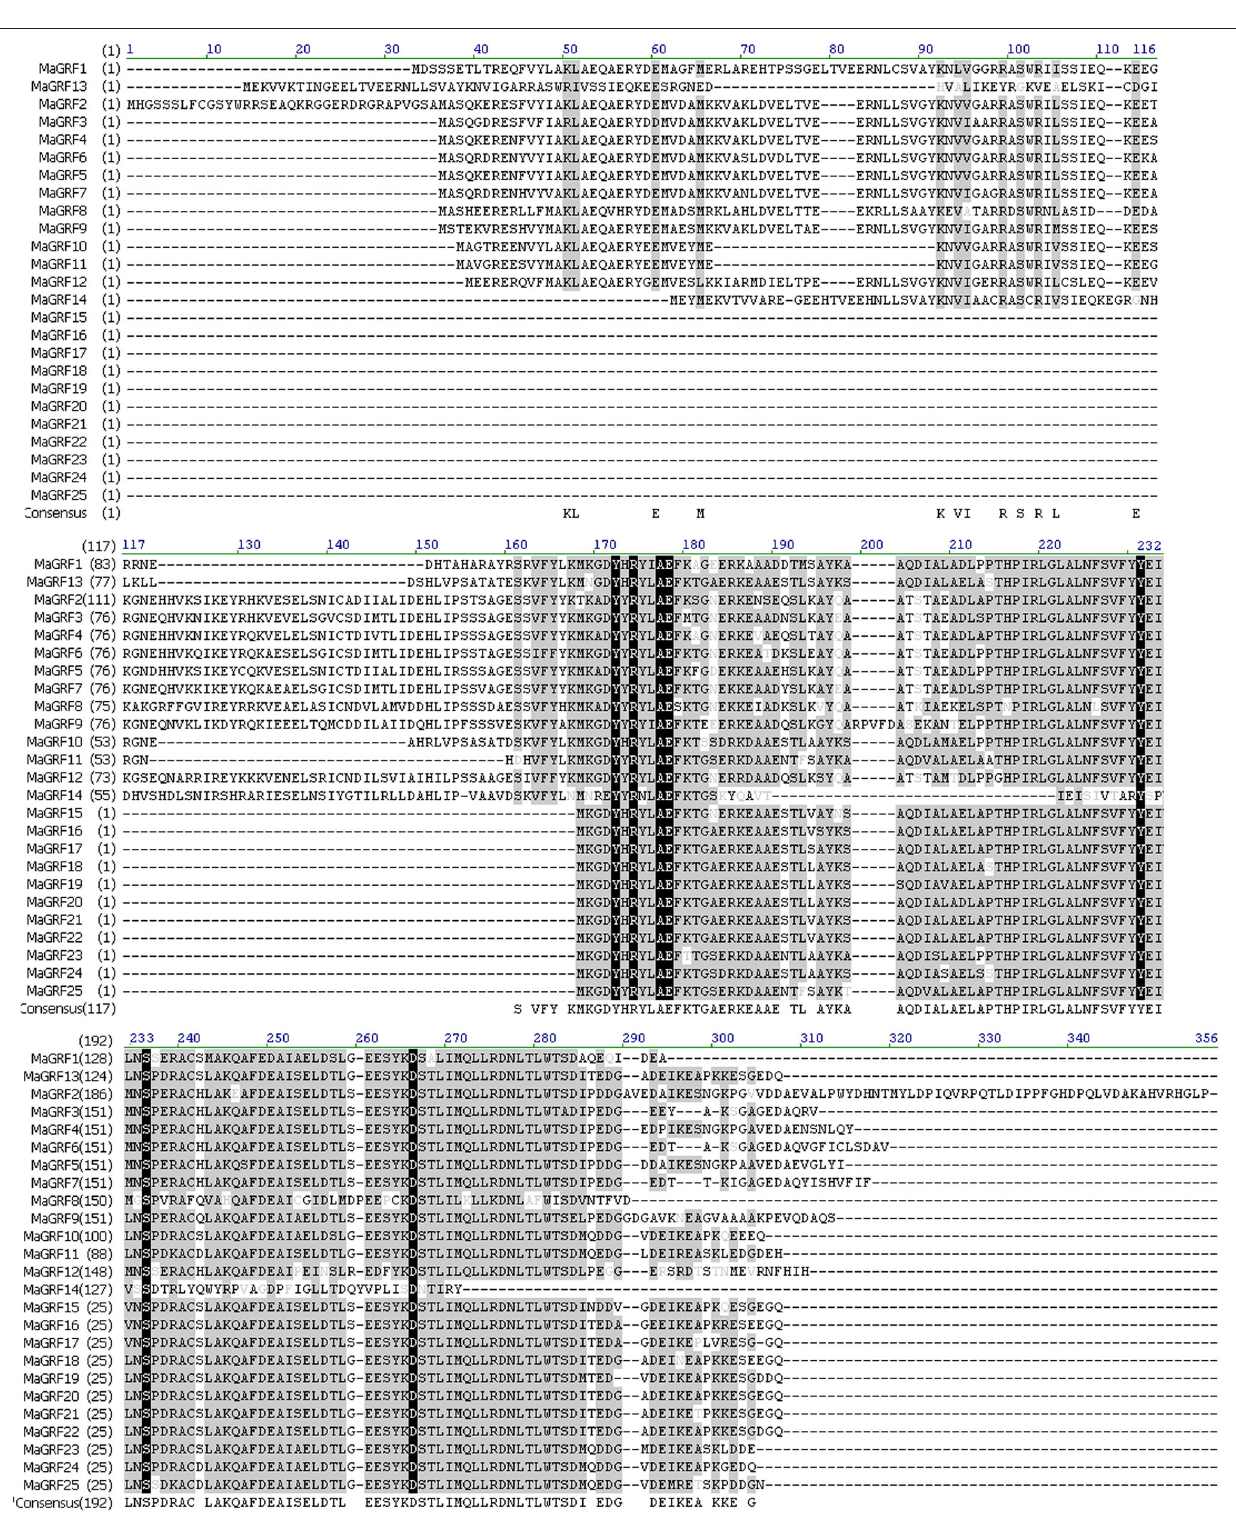
Frontiers in Plant Science |